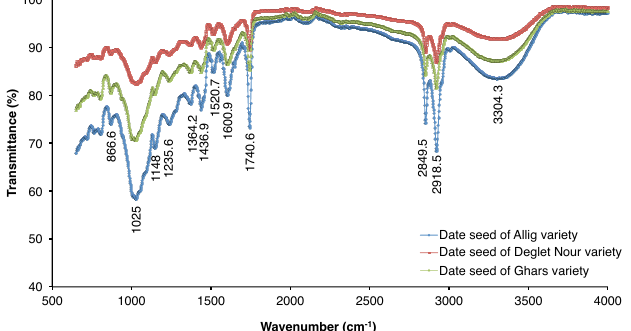
Figure 2. Fourier Transform Infrared (FTIR) spectra of three date seed varieties (Allig, Ghars, and Deglet